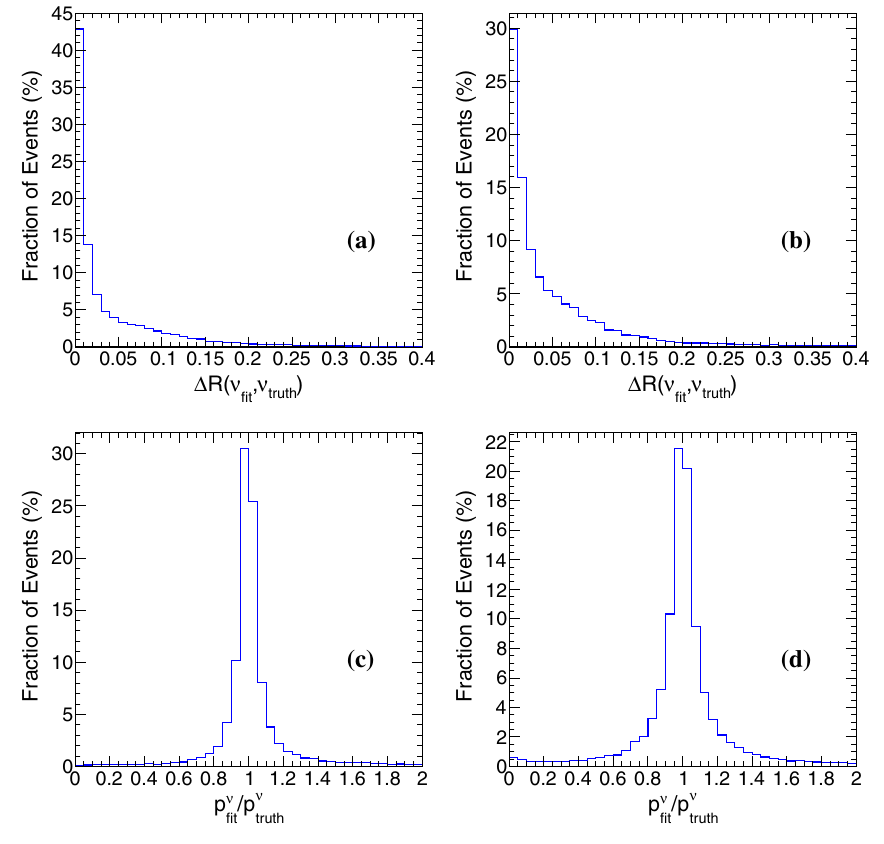
Fig. 3 The Δ R between the reconstructed and true neutrino momenta ( a , b ), and the ratio of them ( c , d ), for the τ → πν ( a , c ) and τ → ρν ( b , d ) decays in the π + ρ